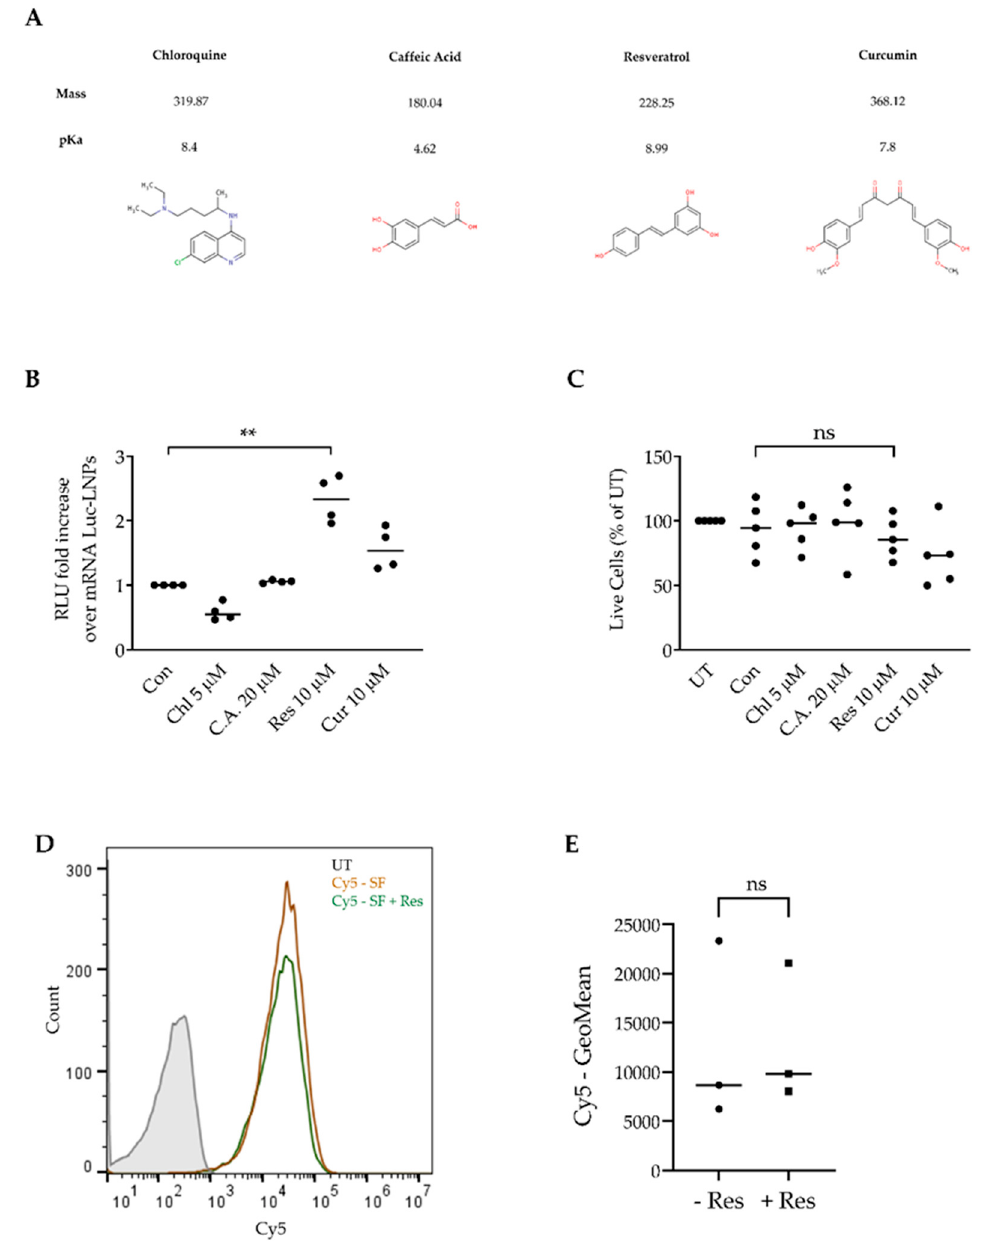
Figure 3. Resveratrol enhances mRNA-LNP transfection into primary CLL cells. ( A ) Chemical structures and properties of chloroquine, caffeic acid, resveratrol and curcumin. Taken from the Chemical Entities of Biological Interest (ChEBI) database. ( B ) Comparison of fold change in the expression of Luc-mRNA. CLL patient samples ( n = 4) were transfected in serum-free media with 2.5 µg/mL of mRNA-luciferase encapsulated in LNPs (mRNA-Luc). After 1 h, resveratrol (Res), caffeic acid (C.A), curcumin (Cur), and chloroquine (Chl) were added at a concentration of 10 µM, 20 µM, 10 µM, and 5 µM, respectively. After 3 h, FCS was replenished to a total of 10% of well volume. Luciferase expression was determined 24 h post transfection by a luminometer; measured in relative luminescence units (RLU). ( C ) Viability was measured 48 h post transfection by propidium iodide (PI) and annexin-V staining, as a percentage of the untreated sample; determined by flow cytometry. ( D ) Resveratrol’s effect on LNP uptake (representative image). Primary CLL cells were incubated in serum-free conditions in 37 °C with 4 µg/mL NC-Cy5-LNPs for 1 h. After 1 h, resveratrol was added. After 3 h, Cy5 fluorescence was measured by flow cytometry. ( E ) Comparison of geometric mean of Cy5 fluorescence after resveratrol addition. For all experiments: (*) p < 0.05, (**) p < 0.01 (two-sided Student’s t -test).